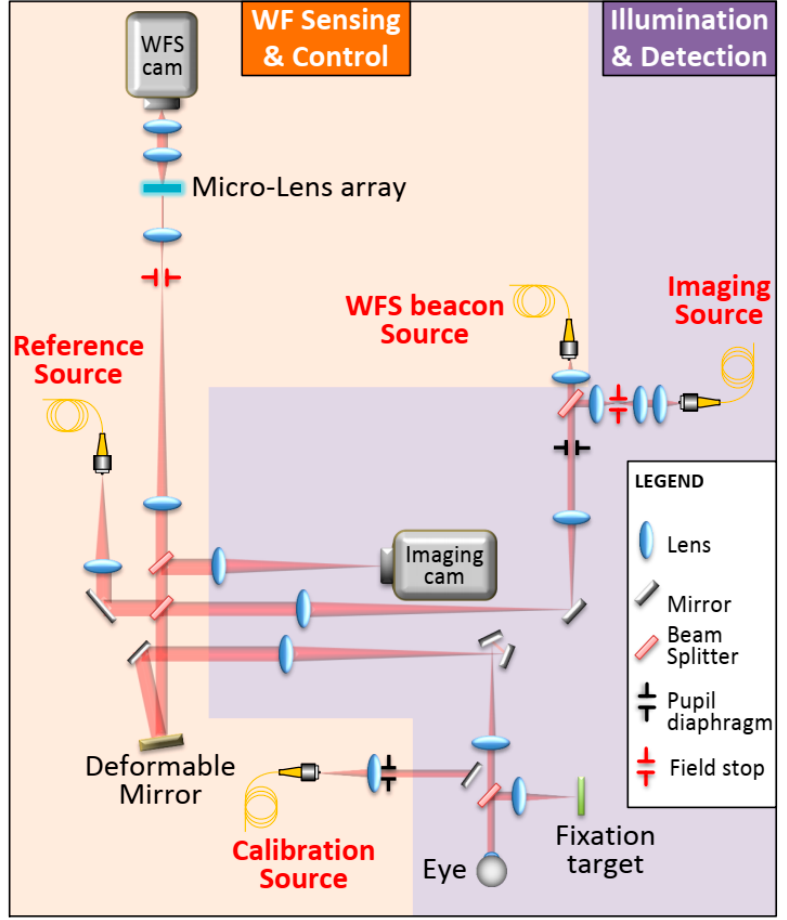
Figure 24. Scheme of AO flood illumination ophthalmoscope. Figure reused from Ref. [124] under the terms of the OSA Open Access Publishing Agreement, © 2019 Optical Society of America.